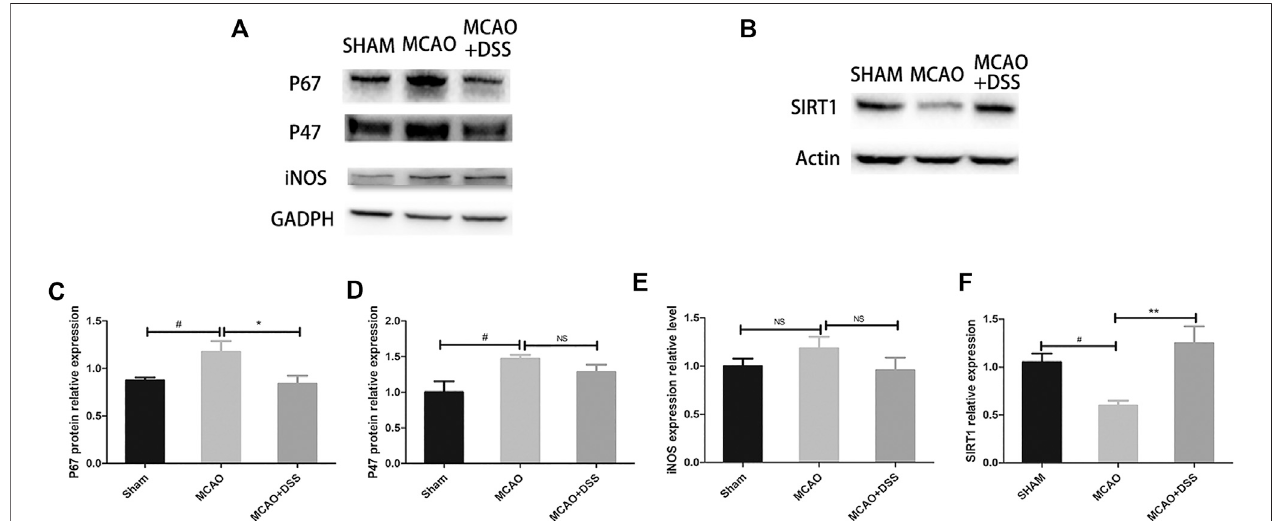
FIGURE 4 | DSS treatment inhibited the expression of NADPH oxidase subunit p67 phox and up-regulated SIRT1 but had no effect on p47 phox and iNOS in MCAO ischemic brains. Sham: sham control group; MCAO: MCAO ischemia-reperfusion group; MCAO + DSS: MCAO plus DSS ethanol extract treatment. The rats were subjected to 2 h of MCAO ischemia plus 22 h of reperfusion. The DSS ethanol extract at the dosage of 12 g/kg was orally administrated into the rats at 30 min before reperfusion after 1.5 h MCAO ischemia. (A) Representative immunoblot results of p67 phox , p47 phox , and iNOS; (B) Representative immunoblot results of SIRT1; (C – F) Statistical analysis for the expressions of p67 phox , p47 phox , iNOS and SIRT1. Vs. Sham control, # p < 0.05, Vs. MCAO, * p < 0.5, ** p < 0.01, n (cid:2) 4 in each group.